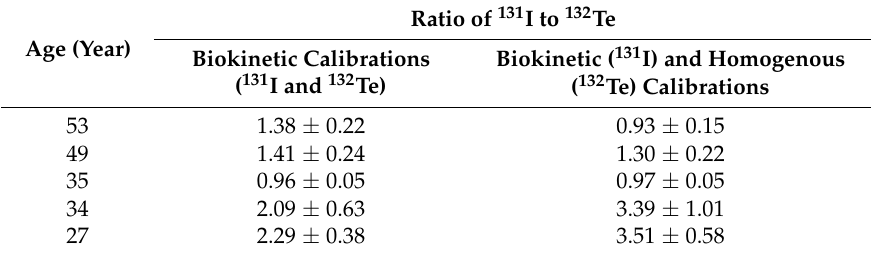
Table 5. The decay corrected ratios of 131 I to 132 Te to 17:00 on 15 March 2011.